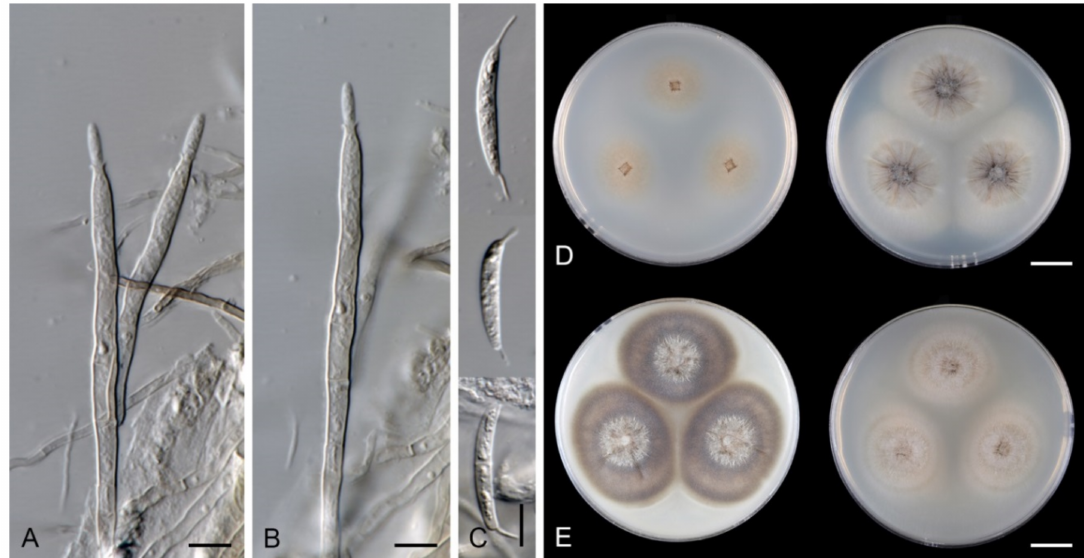
Figure 4. Arcuatospora sp 1. (CBS 694.74). ( A , B ) conidiophores ( C ) conidia ( D , E ) colonies. Images: ( A – C ) on CMA with Urtica stems after 7 weeks; ( D ) colonies on CMD and MLA after 4 weeks (from left to right); ( E ) colonies on OA and PCA after 4 weeks (from left to right). Scale bars: ( A – C ) 5 µ m; ( D , E ) 1